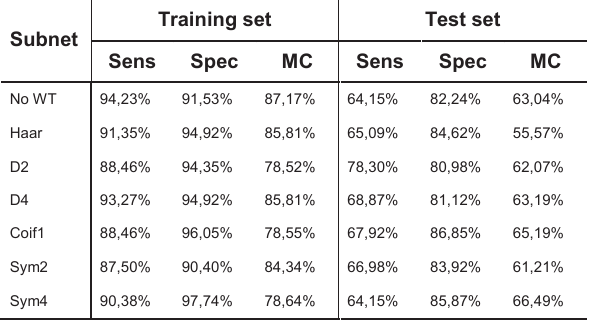
Table 3. Inferolateral ischemia MLP results Training set Test set Subnet Sens